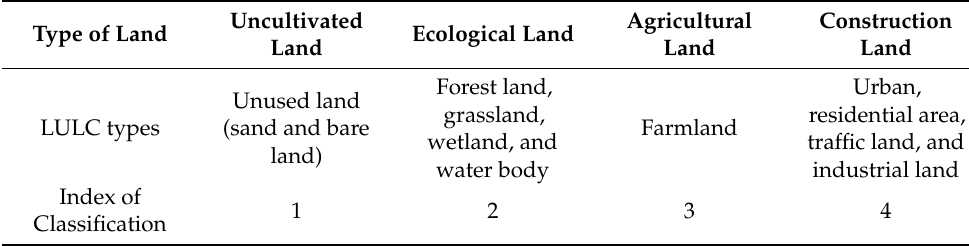
Table 2. Land resource use types and grades. Type of